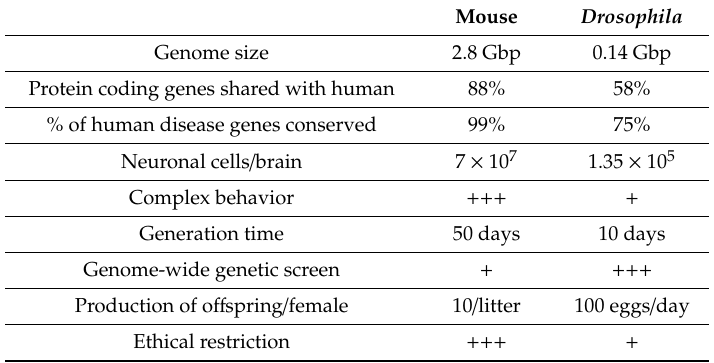
Table 1. Comparison of mouse ( M. musculus ) and Drosophila ( D. melanogaster ) as model organism.